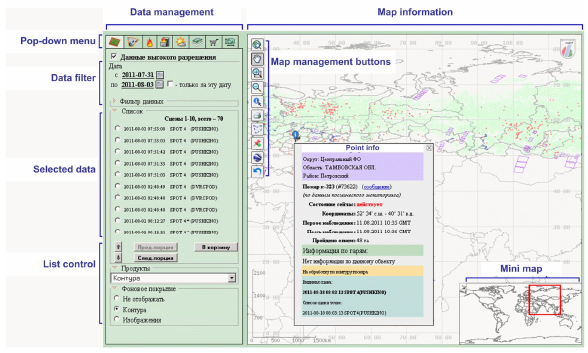
Fig.4. Basic type of